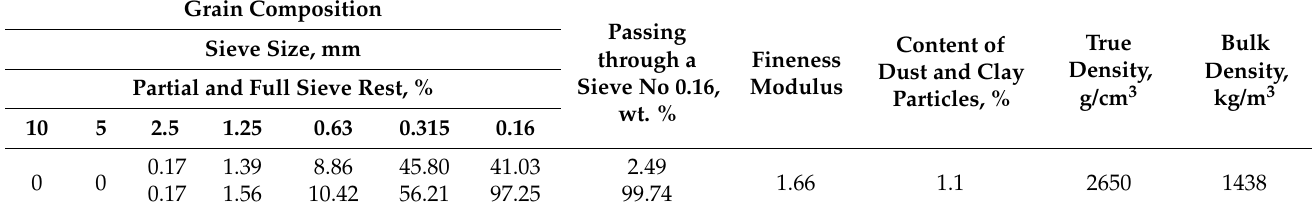
Table 4. Physical characteristics of dense fine aggregate.